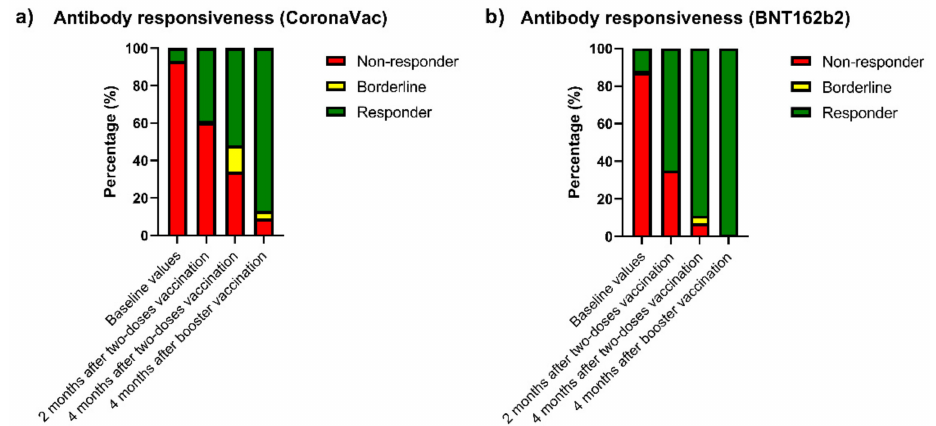
Figure 2. Vaccine responsiveness before and after two vaccine doses and booster doses in end-stage renal disease patients in hemodialysis. Proportion of immune responsiveness before vaccination, 2 and 4 months after a two-dose vaccination schedule, and 4 months after a booster dose. All patients received the BNT162b2 vaccination as the booster dose, regardless of the previous vac- cination. Patients were classified as responder (antibody titers ≥ 2 U/L–green bar), borderline (1–1.99 U/L–yellow bar), or non-responder (0–0.99 U/L–red bar). ( a ) Patients who received the CoronaVac vaccine and ( b ) patients who received the BNT162b2 vaccine. Data are expressed as